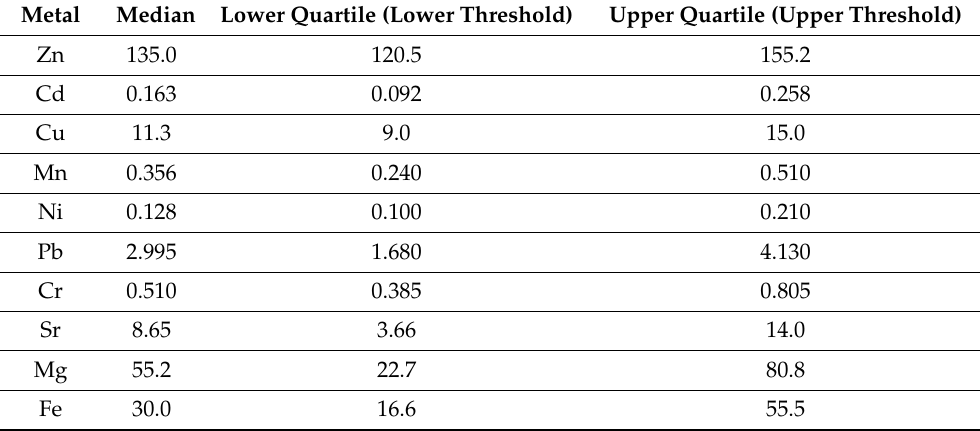
Table 1. Variational indicators of metal content in hair ( µ g/g) *.